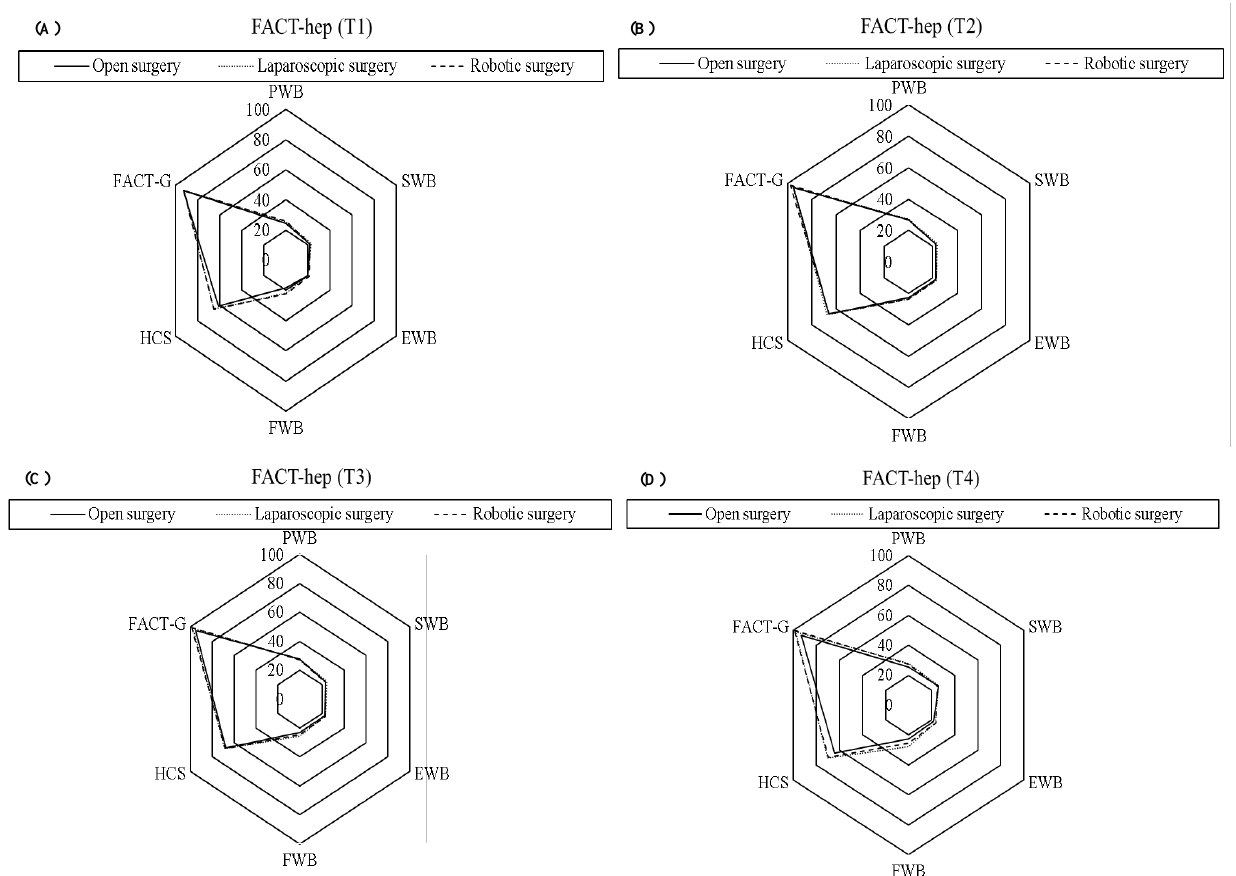
Figure 2. The radar diagram showed the longitudinal changes in the Functional Assessment of Cancer Therapy- Hepatobiliary (FACT-Hep) in hepatocellular carcinoma patients compared among three surgery types at different time points. ( A ) at preoperative (baseline); ( B ) at 6th month post- operative; ( C ) at 2nd year postoperative; ( D ) at 5th year postoperative. PWB, physical well-being; SWB, social/family well-being; EWB, emotional well-being; FWB, functional well-being; HCS, hep- atobiliary cancer subscale. T1: preoperative; T2: postoperative 6-month; T3: postoperative 2-year; T4: postoperative 5-year